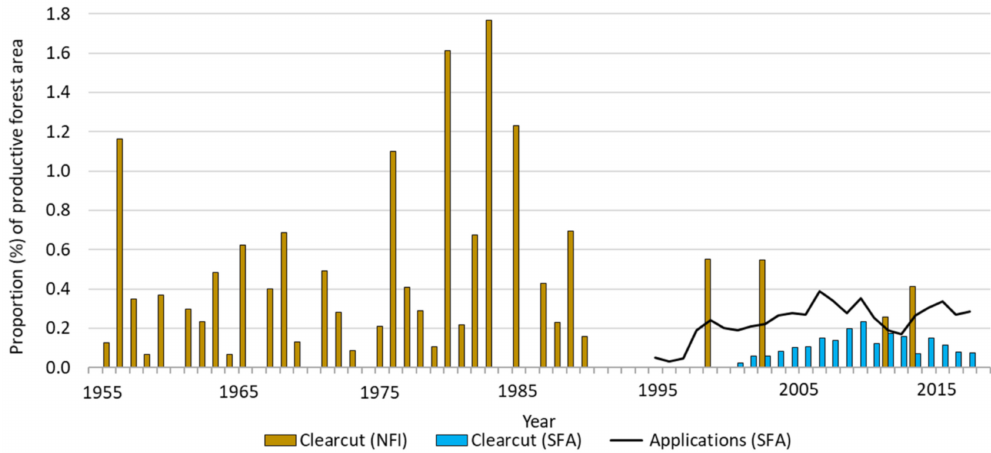
Figure 7. Annual clear-cut area 1955–2018 above the mountain forest border based on plot-based field data from the Swedish National Forest Inventory, annual clear-cut area 1995–2018 based on the Swedish Forest Agency statistical database [51], and annual clear-cut applications 1995–2018 based on the Swedish Forest Agency statistical database [51]. Note that clear-cut applications do not necessarily become clear-cut the same year as the application was registered, and that a proportion of the applications do not result in